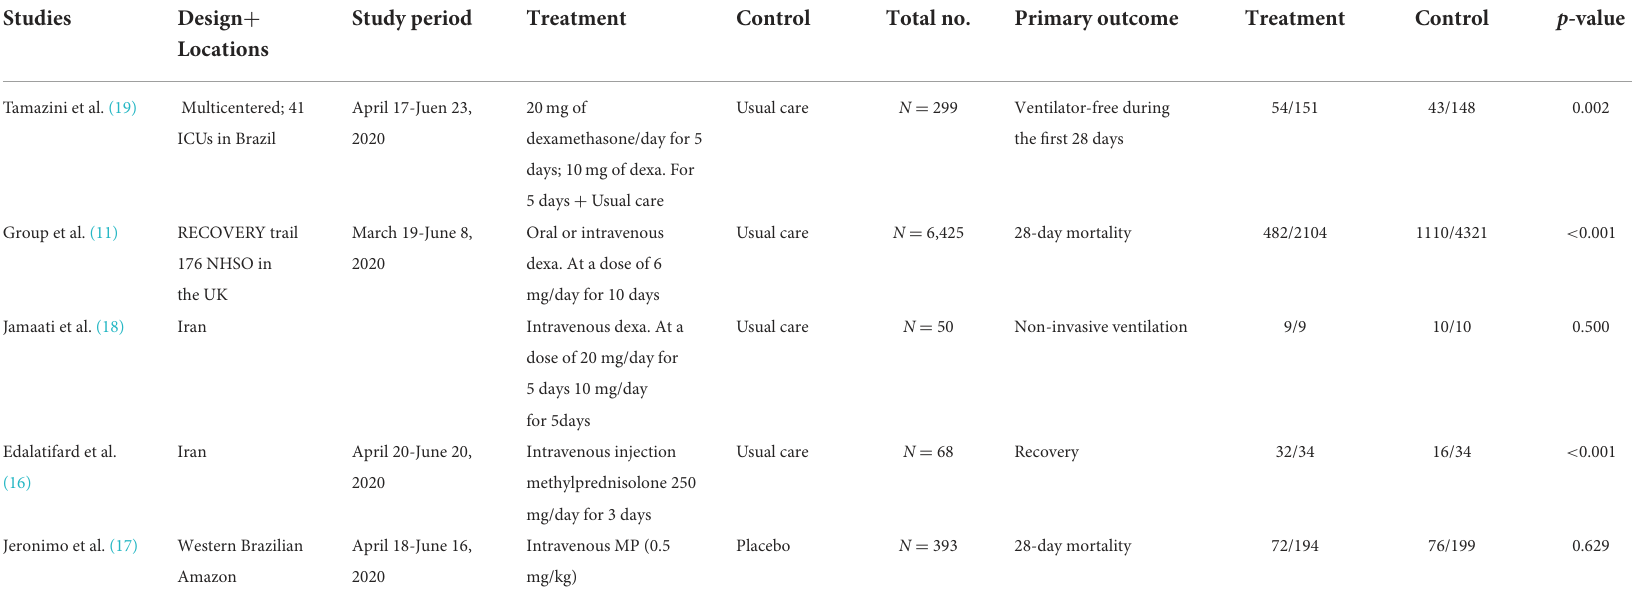
TABLE 1 Included randomized controlled clinical trials